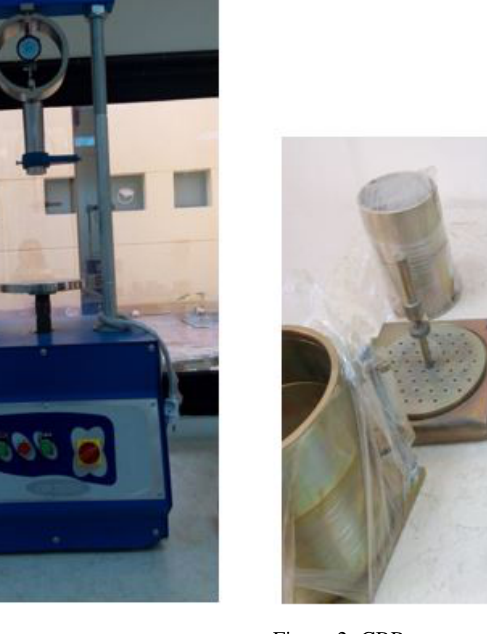
Figure 2. CBR test apparatus